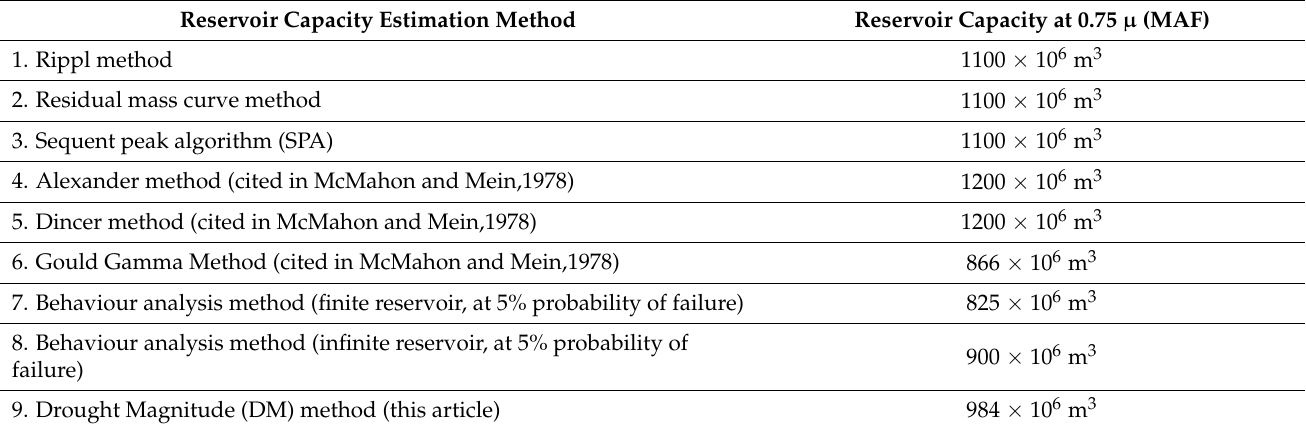
Table 6. Comparison of reservoir capacity by different methods at the monthly